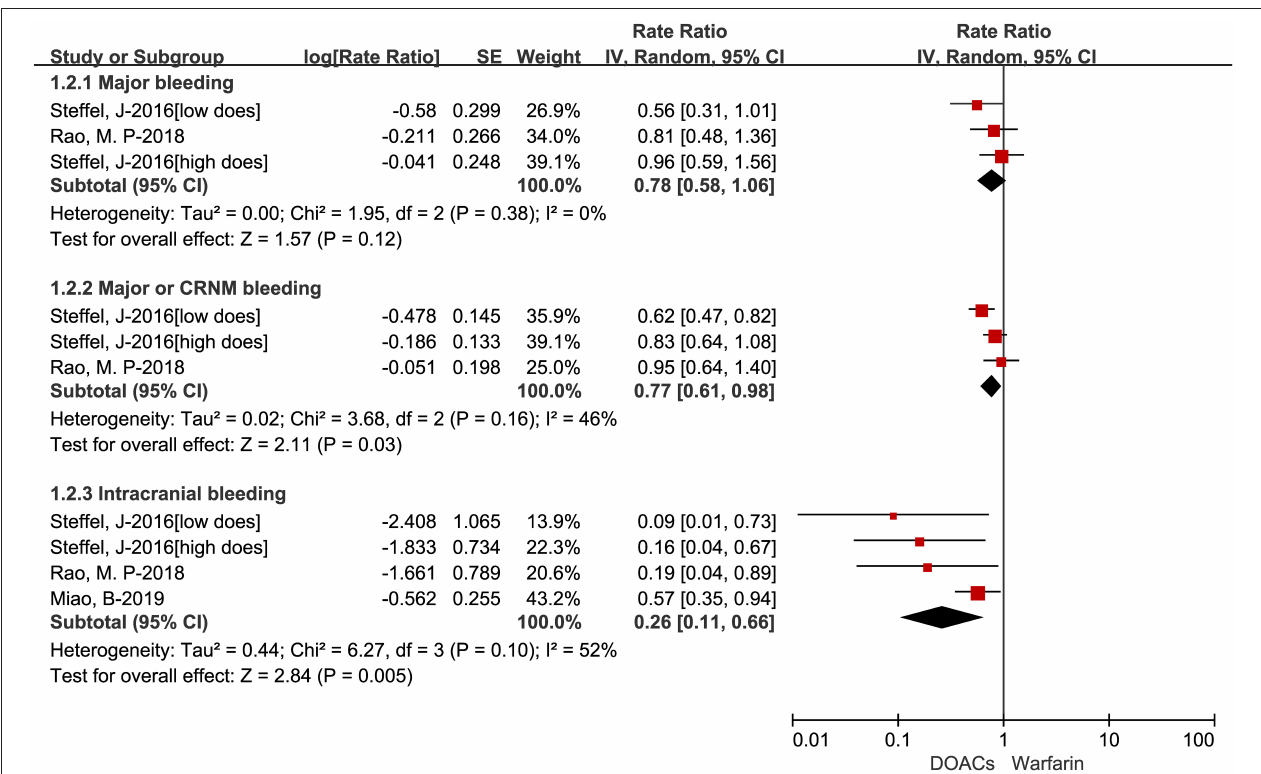
FIGURE 4 | Adjusted safety data of direct oral anticoagulants compared with warfarin among atrial fibrillation patients at risk of falling. DOACs, direct oral anticoagulants; CRNM, clinically relevant nonmajor bleeding.